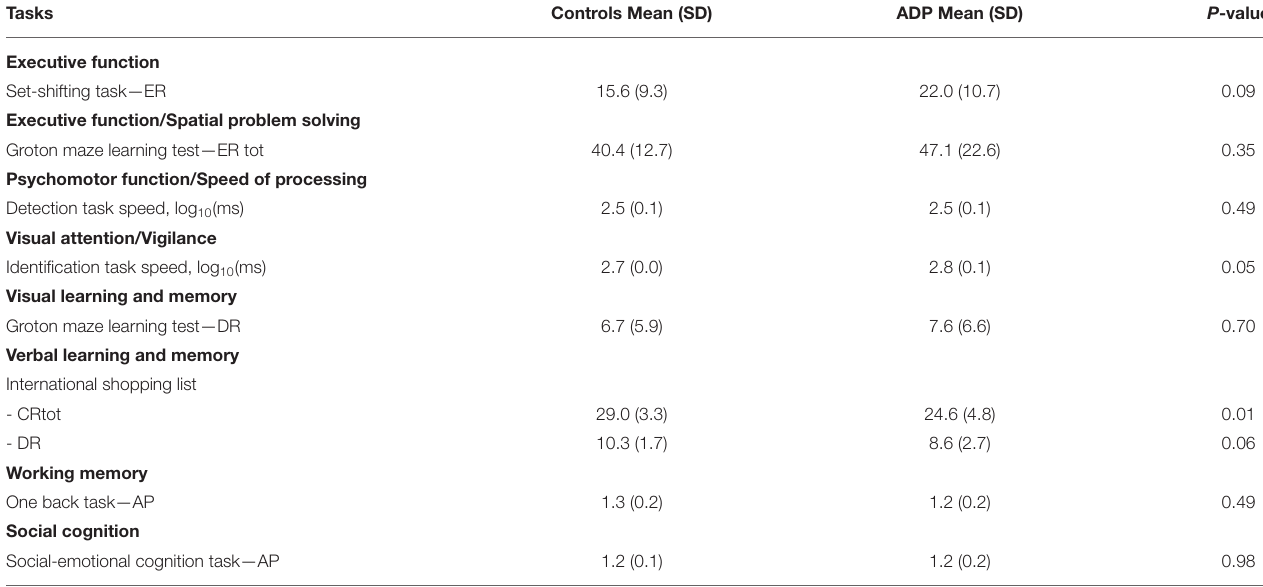
TABLE 3 | CogState neuropsychological performances for controls ( n = 18) and alcohol-dependent patients (ADP) ( n = 18) at D15.